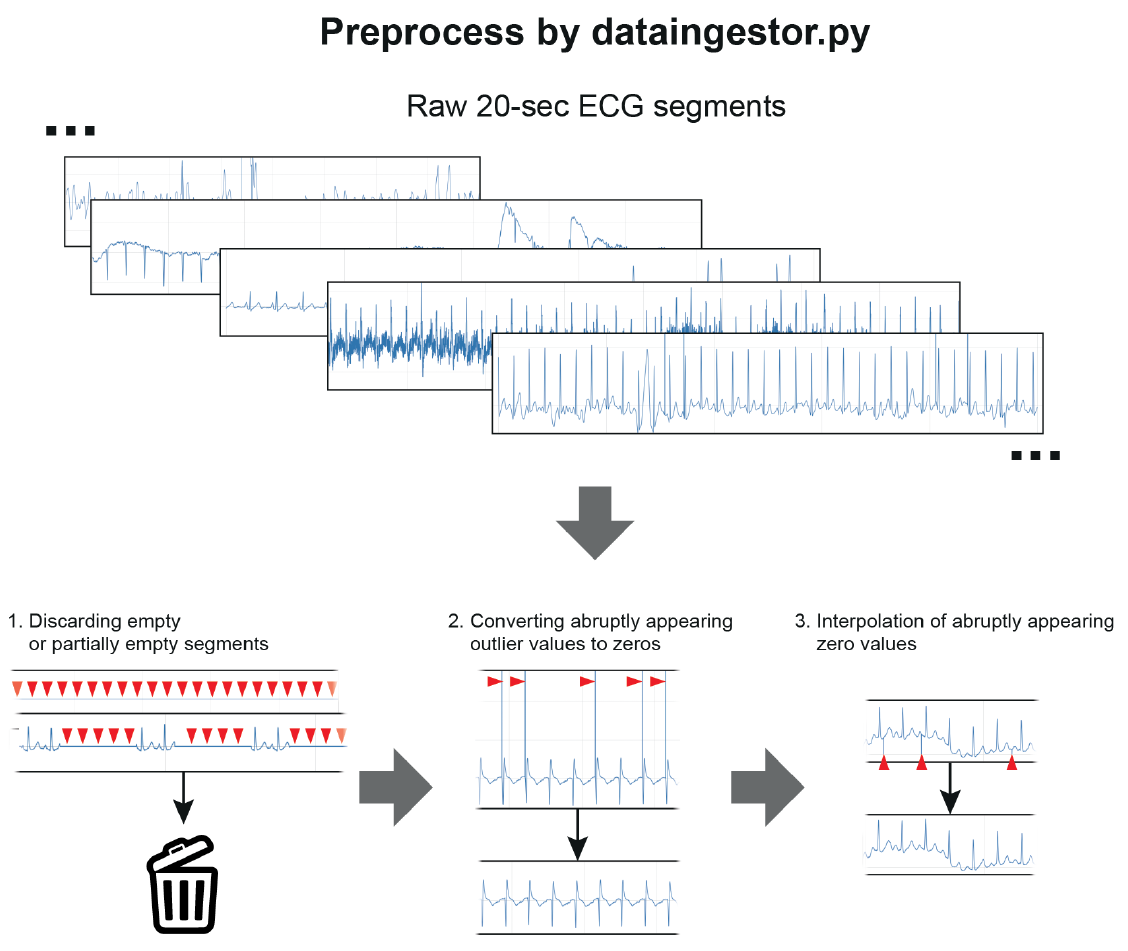
Figure 2. Data cleaning and preprocessing. Red triangles indicate the sites of interest in prepro-